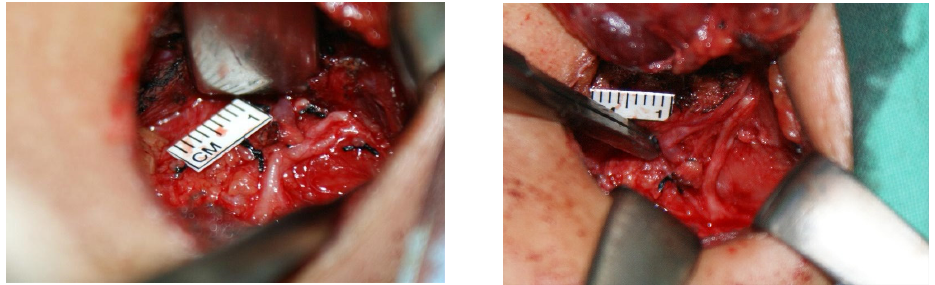
Figure 2. Left non-recurrent laryngeal nerve found during left thyroidectomy, arising from the vagus nerve at the level of the thyroid toward the trachea.